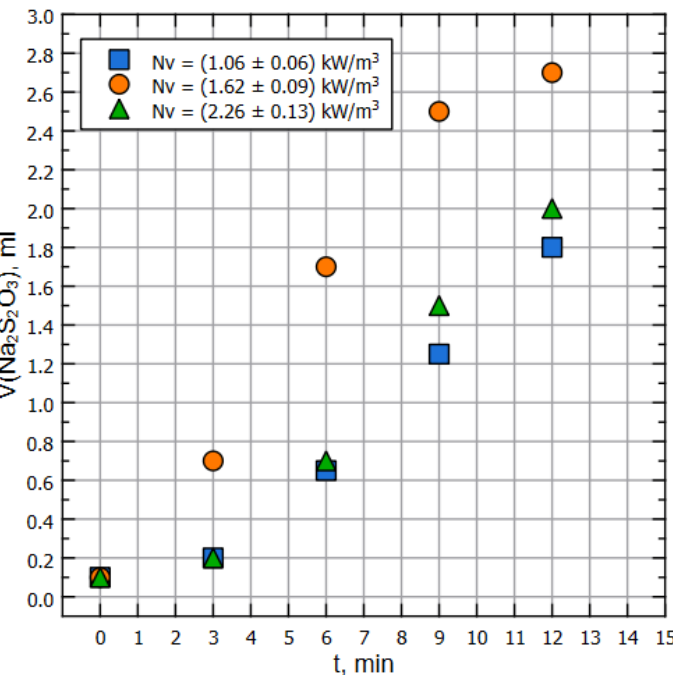
Figure 3. Amount of thiosulfite used for titration, mL per